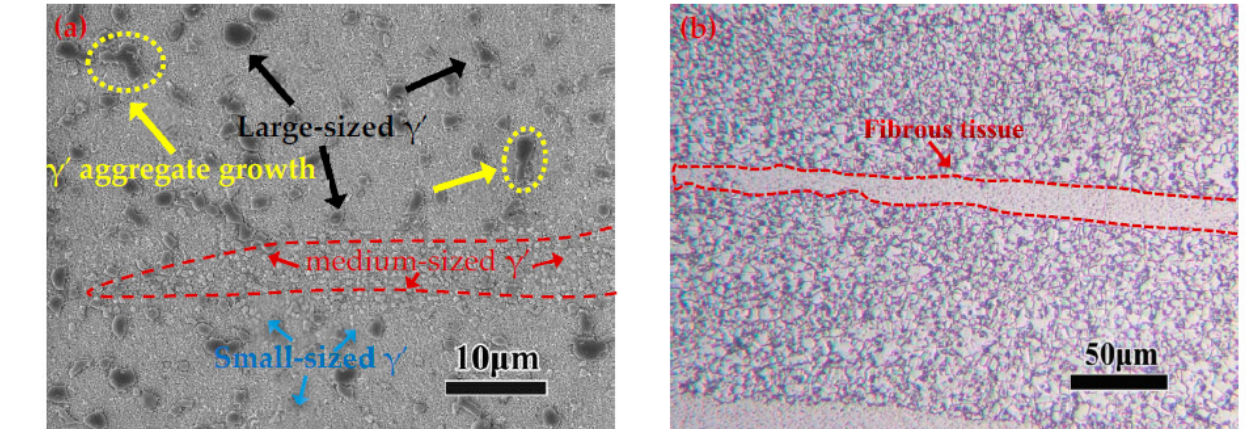
γ (cid:48) phase in the BM, ( b ) Microstructure of the BM. Figure 3. ( a ) Morphology of γ′ phase in the BM, ( b ) Microstructure of the BM. Figure 3. ( a ) Morphology of